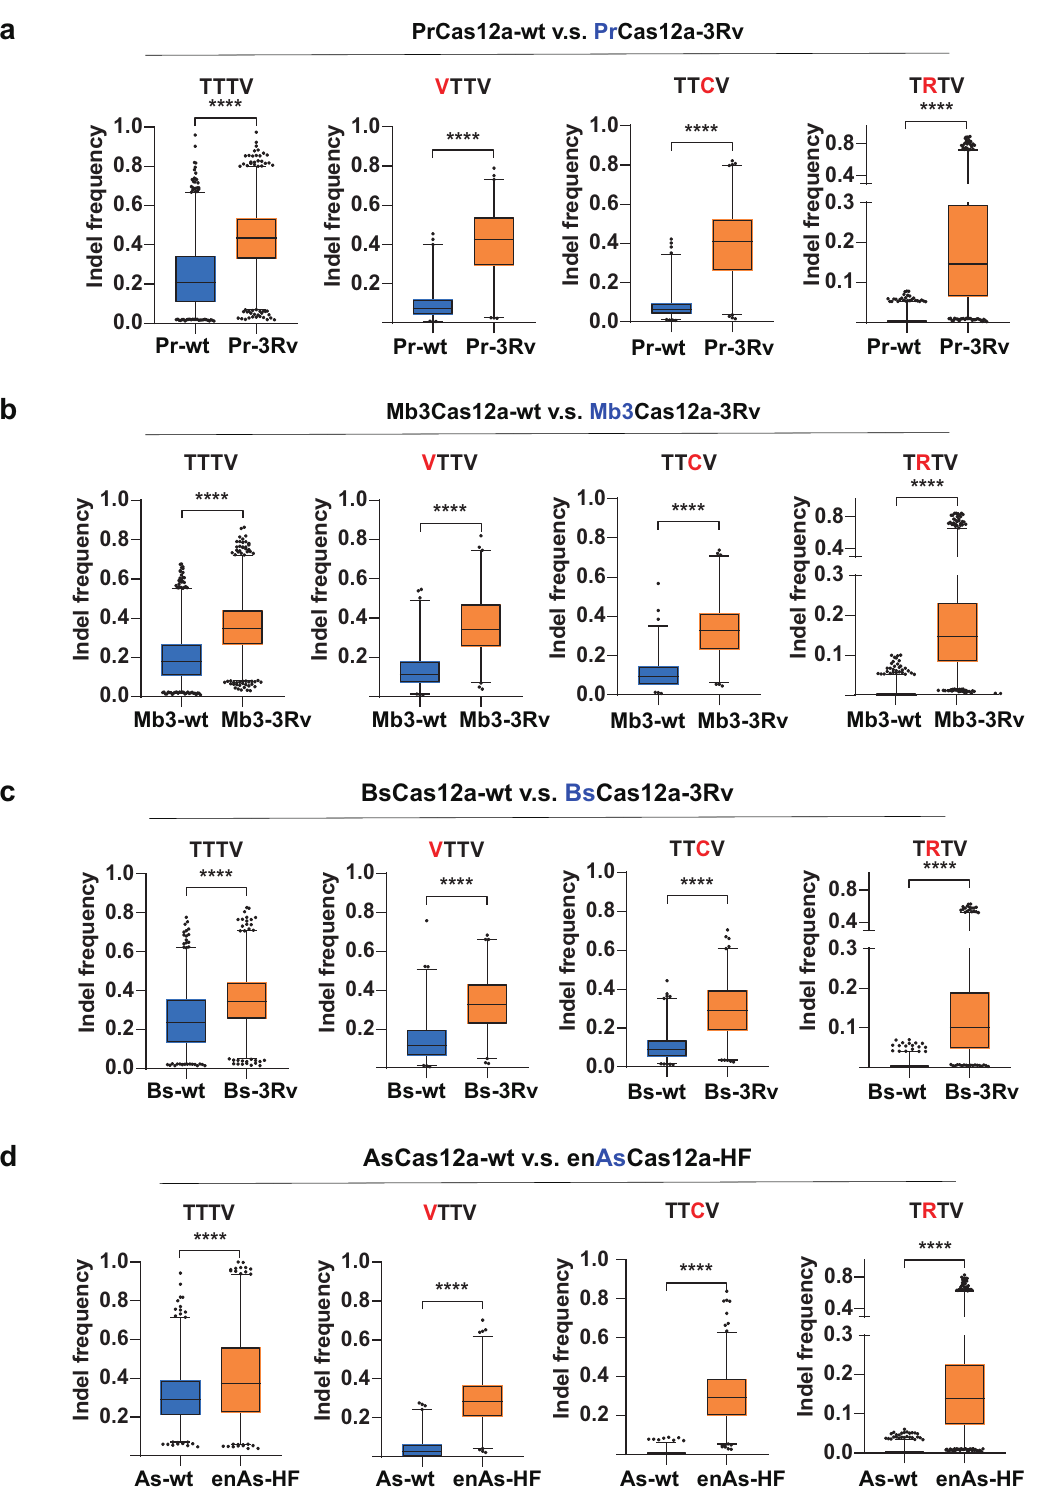
Figure 4. Editing activity comparison between the wild-type (WT) and variants with three arginine substitutions (3Rv) of two Cas12a orthologues (PrCas12a ( a ), Mb3Cas12a ( b ), BsCas12a ( c ), and AsCas12a ( d )) at targets with canonical PAM sequences (TTTV) and non-canonical PAM sequences (VTTV, TTCV, and TRTV) in HEK293T cells. V = A/C/G; R = A/G. The same set of target sites was chosen to evaluate the editing efficiency between WT Cas12a and engineered Cas12a-3Rv mutants. Box-whisker plots: median line, quartiles for box edges, 1–99% whiskers. **** p < 0.0001. For details of sample size and of the statistical analyses, see the Supplementary